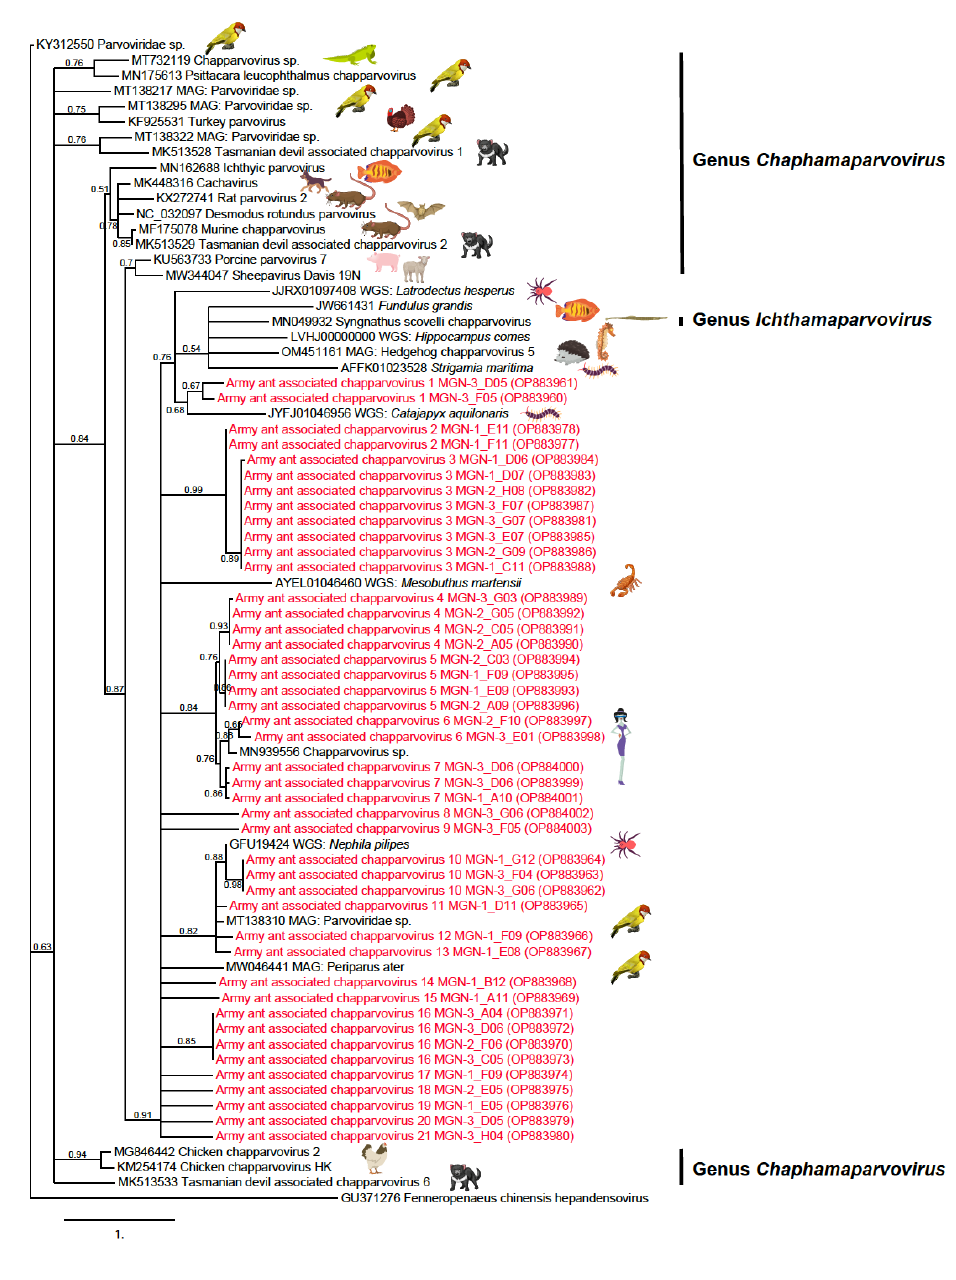
Figure 5 – Phylogeny of the chapparvoviruses. The maximum likelihood tree was generated using alignments of NS1 protein sequences ranging from 214 aa to 823 aa and the WAG substitution model assuming an estimated proportion of invariant sites (of 0.075) and 4 gamma-distributed rate categories to account for rate heterogeneity across sites. The gamma shape parameter was